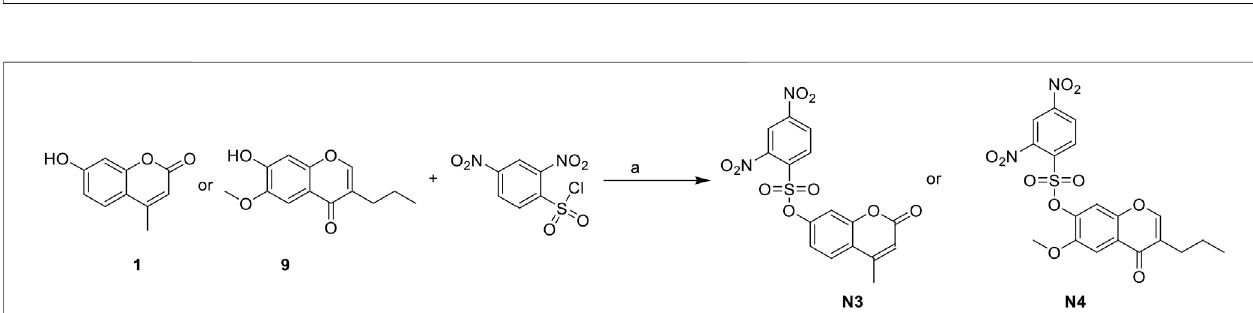
SCHEME 3 | The synthetic route of compounds N1 , N2 . Reagent and conditions: (a) Et 3 N, (dppf)PdCl 2 , 1,4-dioxane, 2-(2,2-dimethyl-1,3,5-dioxaborinan-5-yl)- 5,5-dimethyl-1,3,2-dioxaborinane, 120 ° C, re fl ux, Yields: 75.6% (N1) and 82.2% (N2) .